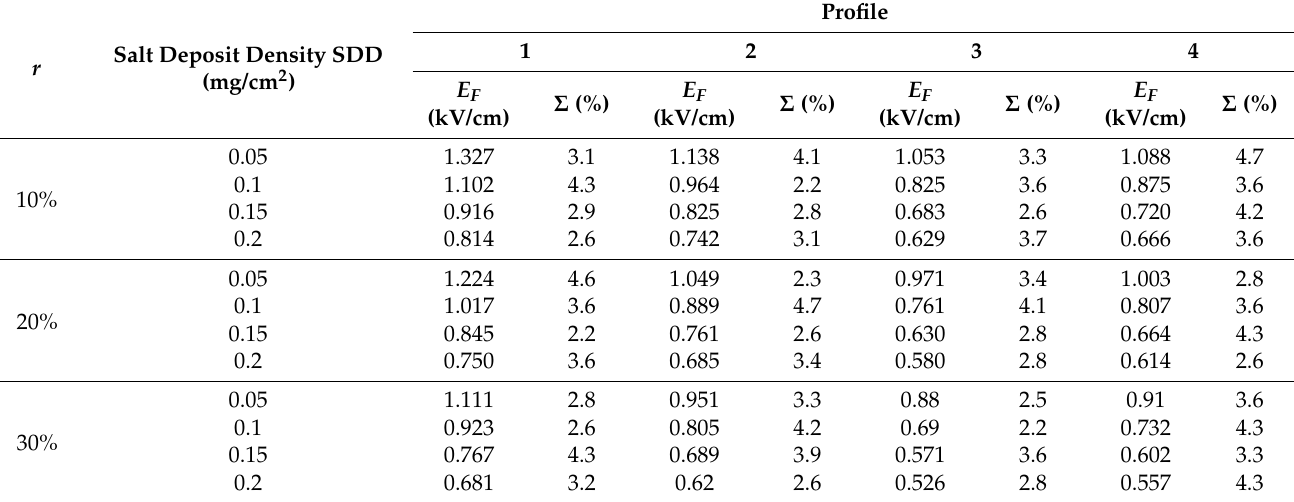
Table 3. Experiment results of coated insulator under different coating damage profile.